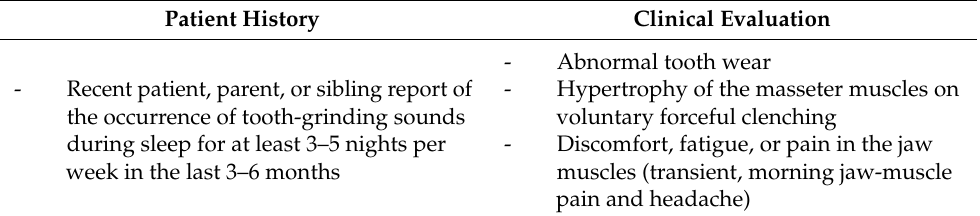
Table 1. AASM clinical diagnostic criteria for SB